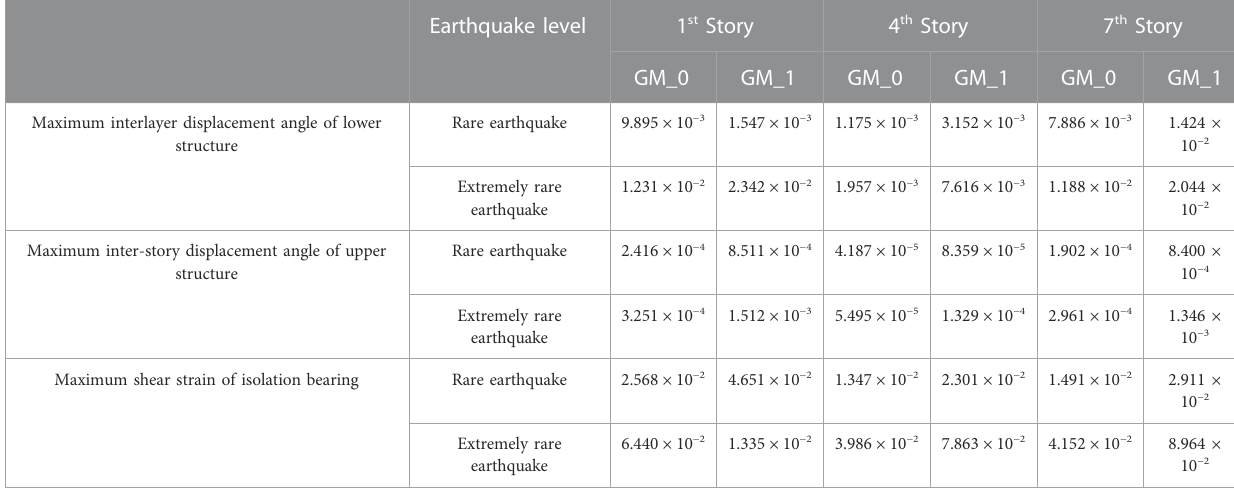
TABLE 10 Failure probability at different bearing stiffness